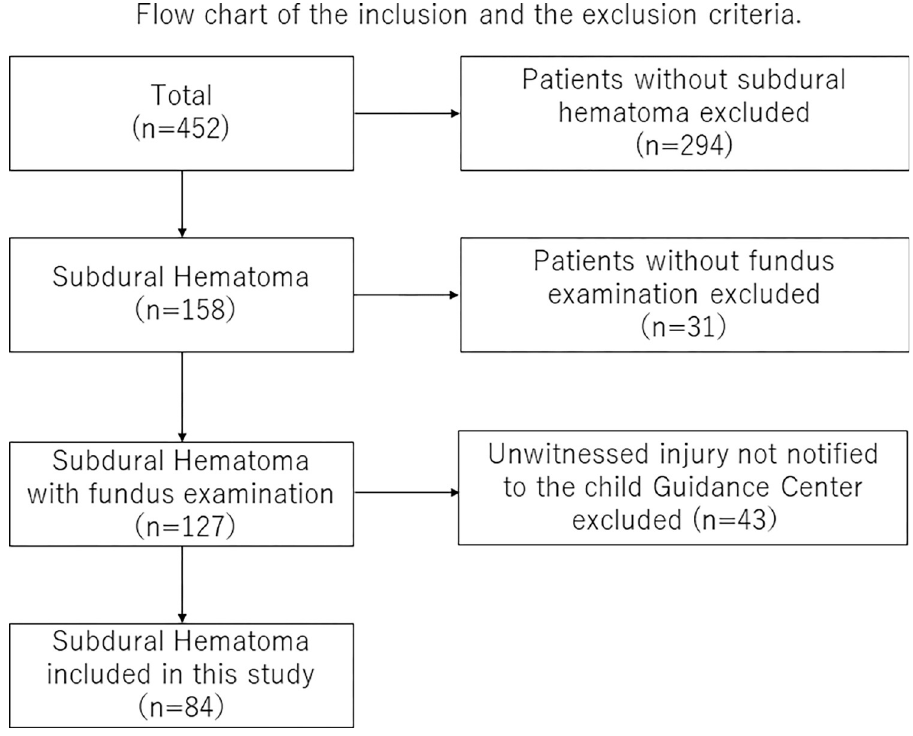
Fig 1. Of the total 452 registered cases, 294 without subdural hematoma were excluded. Of the 158 cases with subdural hematoma, 31 cases without fundus examination were excluded, resulting in 127 cases. In addition, excluding 43 cases that had not been reported to the Child Guidance Center, 84 cases were included in this study.